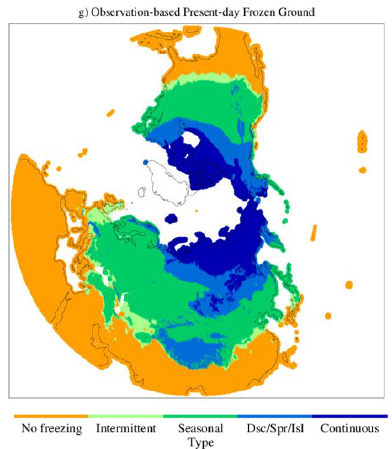
Fig. 2. (g) represents observation-based frozen ground distribution at the present day. Permafrost distribution was taken from the IPA map (Brown et al., 1998), and the seasonally freezing ground is determined by mean monthly air temperature at the surface (Saito et al.,